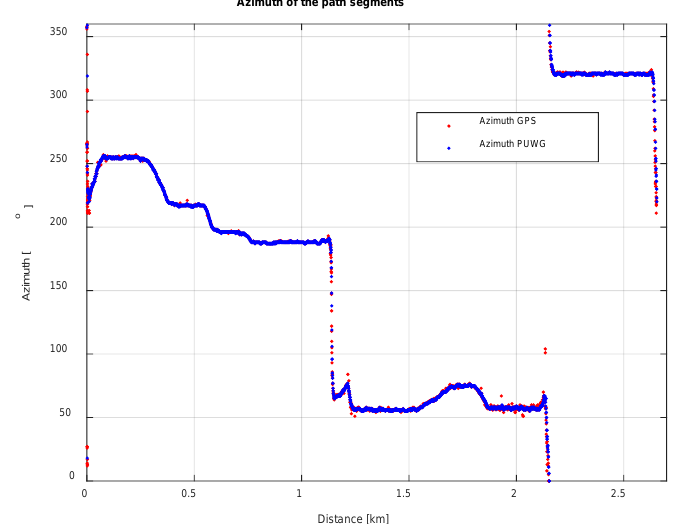
Figure 21. Azimuth calculations.